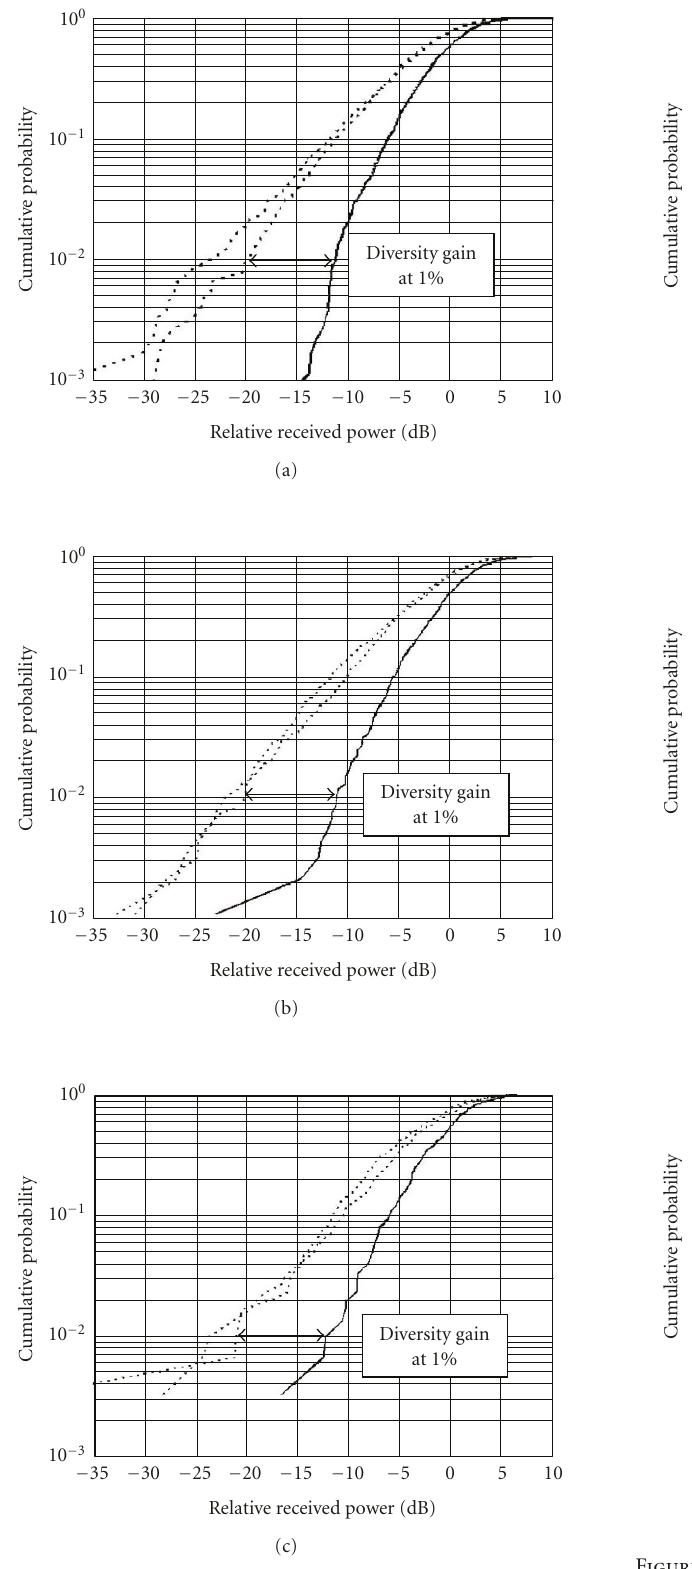
Figure 9: Cumulative probability of the two-antenna systems over a 4MHz bandwidth at 2GHz: (a) without the neutralization line, (b) with the neutralization line between the feeding strips, and (c) with the neutralization line between the shorting strips.